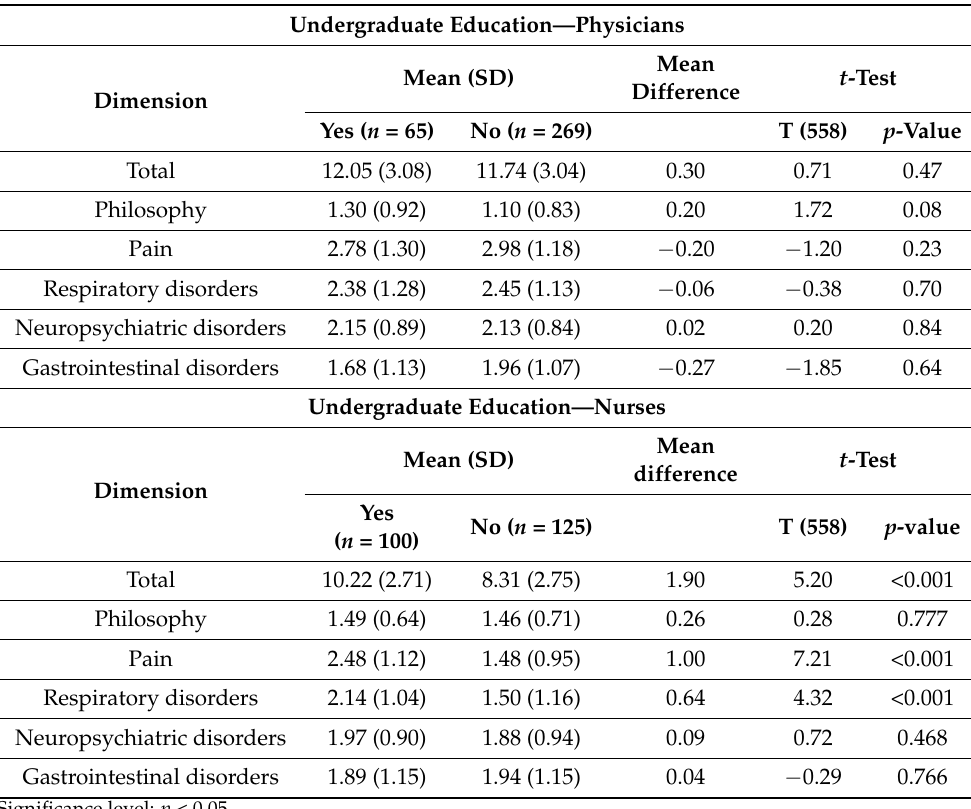
Table 3. Scale scores of PCKT-SV according to palliative care training in the undergraduate education in physicians and